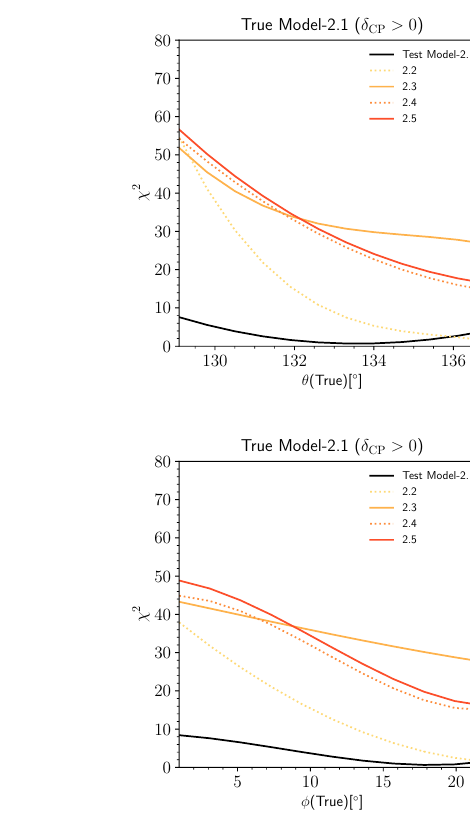
Figure 4 . Comparison among the (cid:12)ve allowed two-parameter models as test models for ESSnuSB using priors in the cases the model parameters (cid:30) (upper row) and (cid:18) (lower row) are minimized and corresponding to the (cid:12)rst (left column) and the second (right column) best-(cid:12)t points in table 8 for Model 2.1 as the true model. For description of each panel, see (cid:12)gure